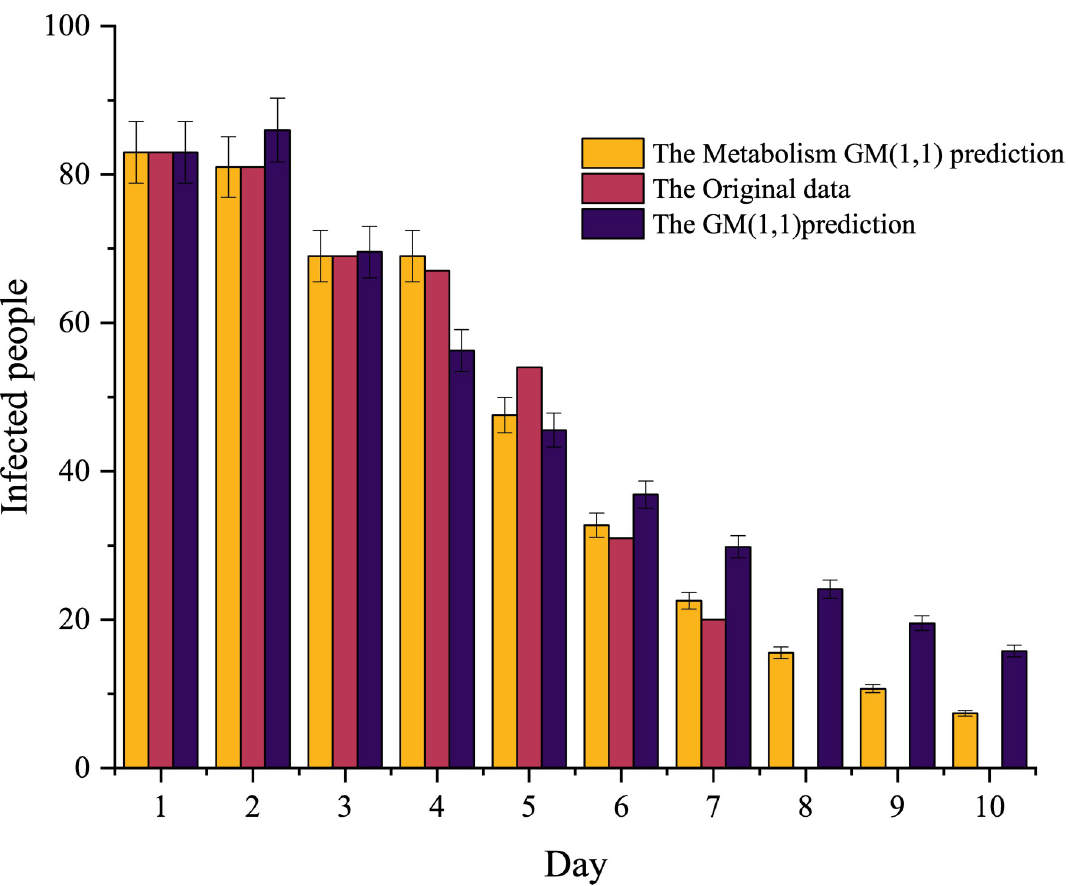
Fig 3. Predicted infected people with error